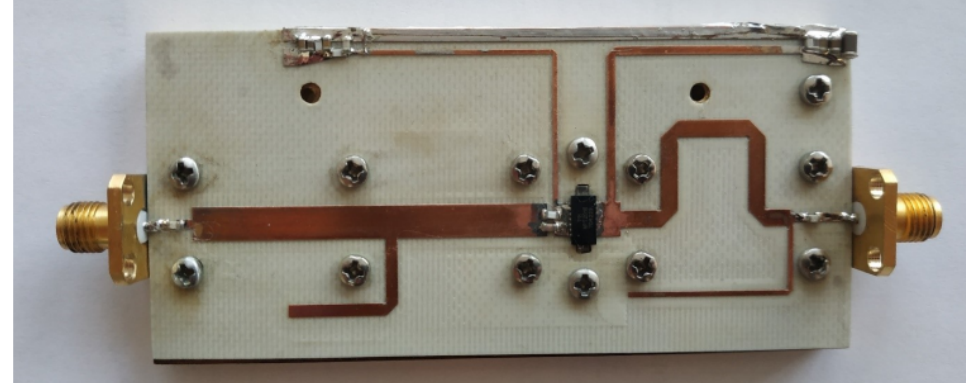
Figure 8. Photography of the test PA with GaN HEMT NPT2018.